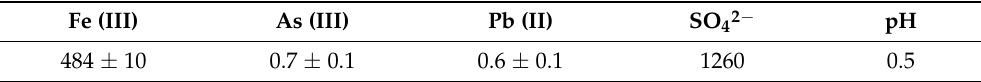
Table 5. Metal concentration (mg/L) in strongly acidic wastewater from coking